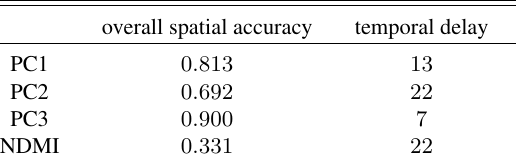
Table 1: validation result